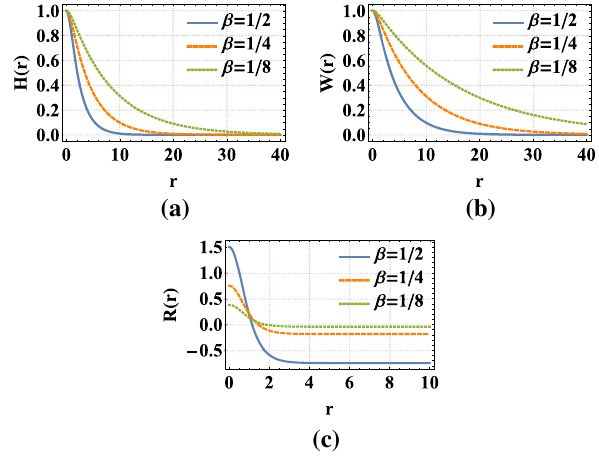
Fig. 3 The metric components (42)–(43), and the curvature scalar (55) in the limit D → 4. a The metric component H ( r ) . b The solution of W ( r ) . c The curvature scalar R ( r ) . The parameter k is fixed to k = 1